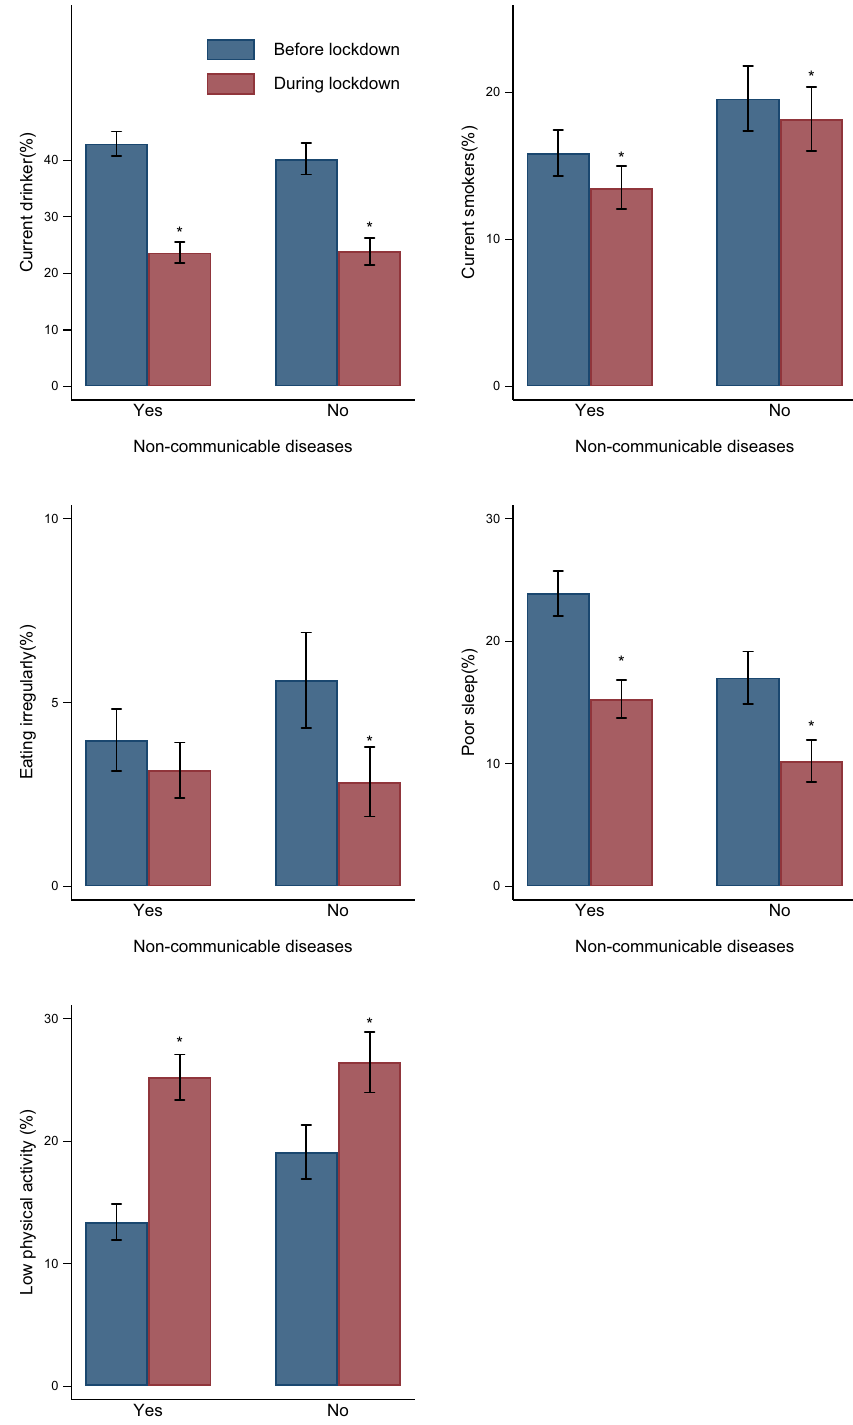
Figure 1. Lifestyle before and during the nationwide COVID-19 lockdown in Hangzhou, China. *p < 0.05, for the difference before and during lockdown using McNemar’s